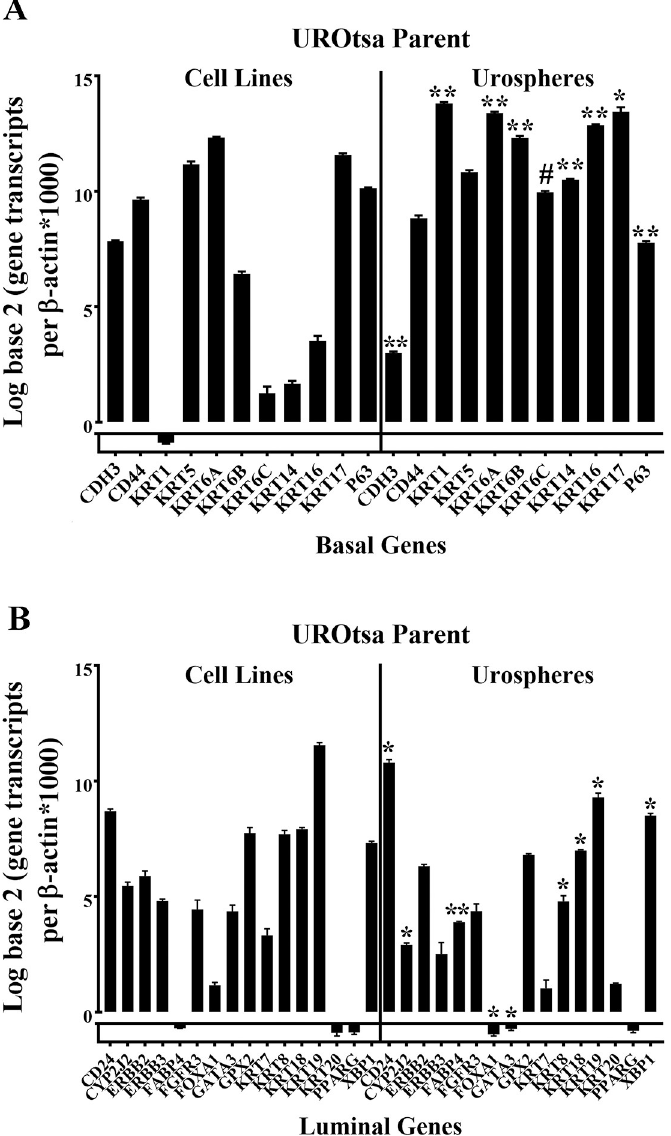
Fig 9. Gene expression analysis of basal and luminal marker genes in the UROtsa parent cell line and urospheres. (A and B). Real-time PCR analysis of basal marker genes (A) and luminal marker genes (B) in the UROtsa parent and the urospheres. The analysis was done in triplicates and is plotted as the mean ± SD. The data is plotted on a log base 2 scale per transcript of β -actin times 1000. � indicates significantly different at p < 0.05 from parent UROtsa cells. # indicates significantly different at p < 0.01 from parent UROtsa cells. �� indicates significantly different at p < 0.0001 from parent UROtsa